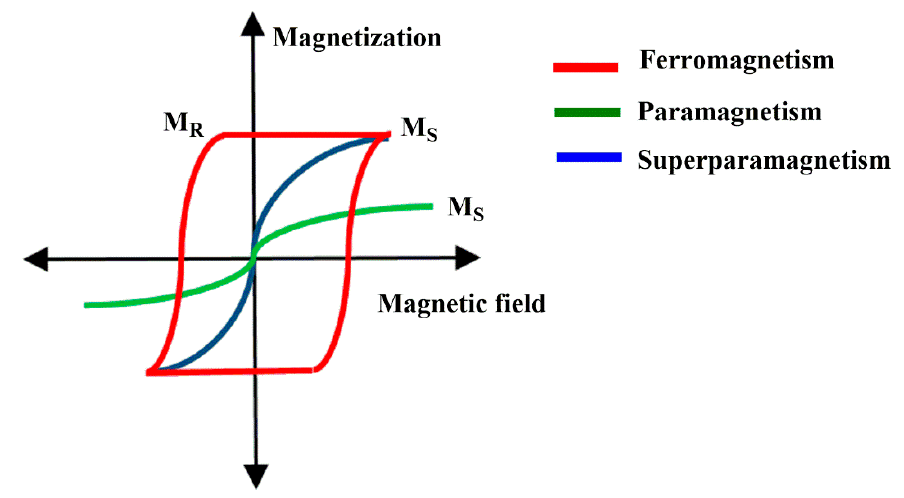
Figure 1. Comparison between magnetization curves of different types of materials: ferro-, para- and superparamagnetics.